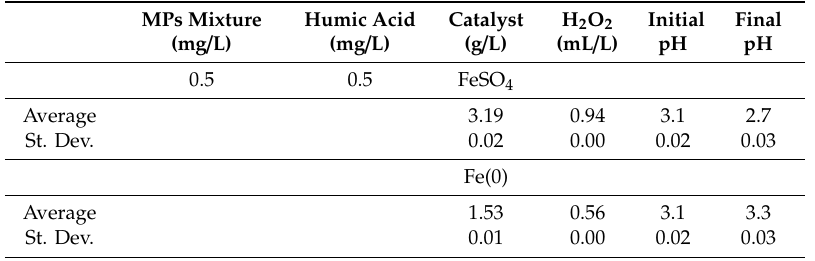
Table 4. Experimental conditions for the sludge volume index